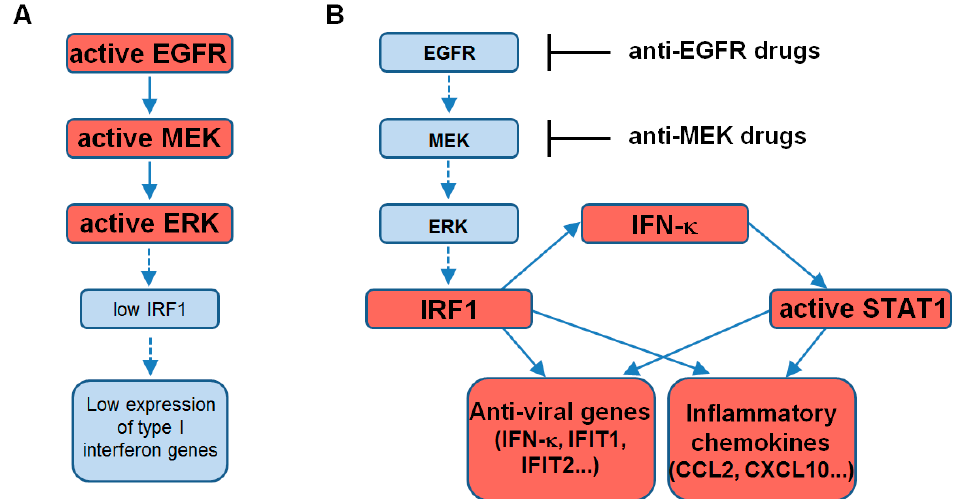
Figure 6. Schematic representation of the impact of EGFR-ERK pathway on the type I interferon response in human keratinocytes. ( A ) Through a molecular mechanism not yet detailed, active EGFR-ERK pathway down-regulates the transcription factor IRF1, thereby keeping under control the expression of genes responsible of the type I interferon response; ( B ) Impairment of the EGFR-ERK pathway due to anti-EGFR and anti-MEK drugs leads to enhanced levels of IRF1. This transcription factor is actively implicated in the expression of the type I interferon gene cluster, including IFN- κ , in its turn responsible of STAT1 activation and eventual up-regulation of genes involved in the anti-viral defense and in the immune response. Dashed arrows indicate suppressed steps in the signaling pathway. T bars indicate drug-mediated inhibition.